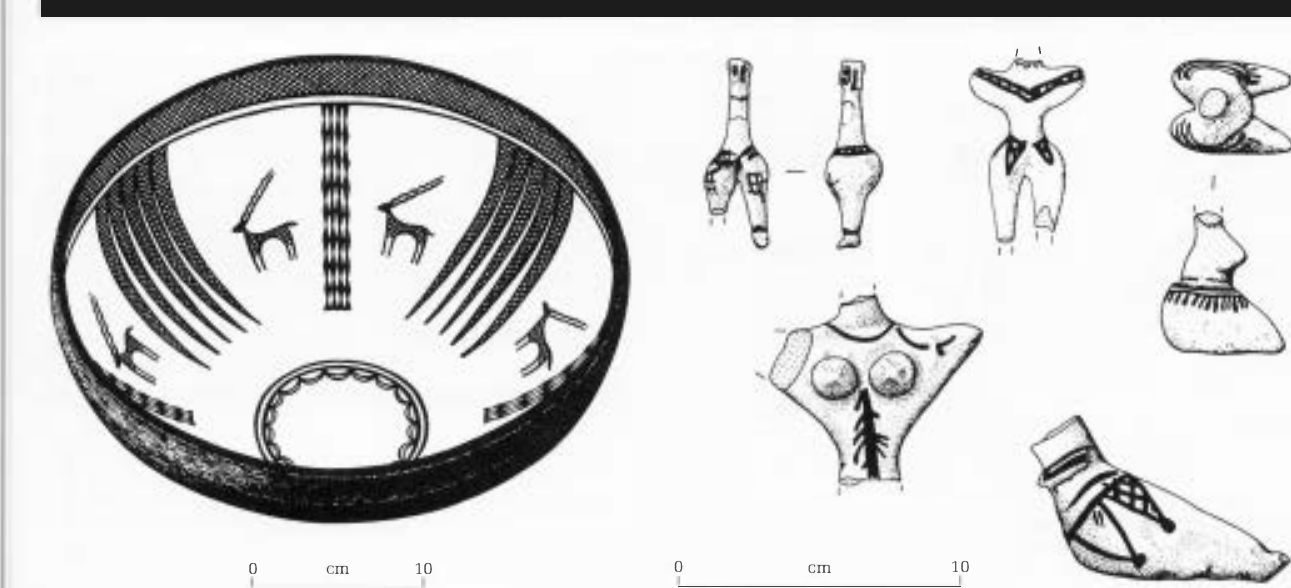
Figure 4 A hand-built bowl from Sheri Khan Tarakai, deco­ rated with mountain goats and other motifs.